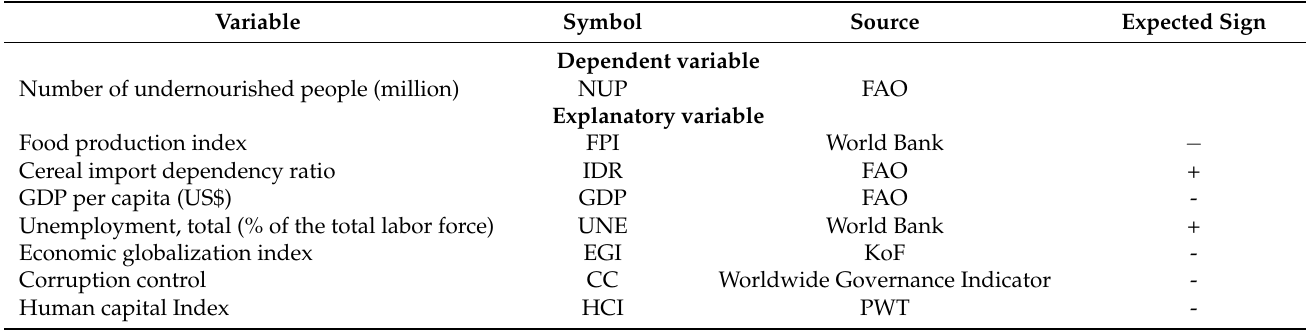
Table 1. Variables and data sources for the